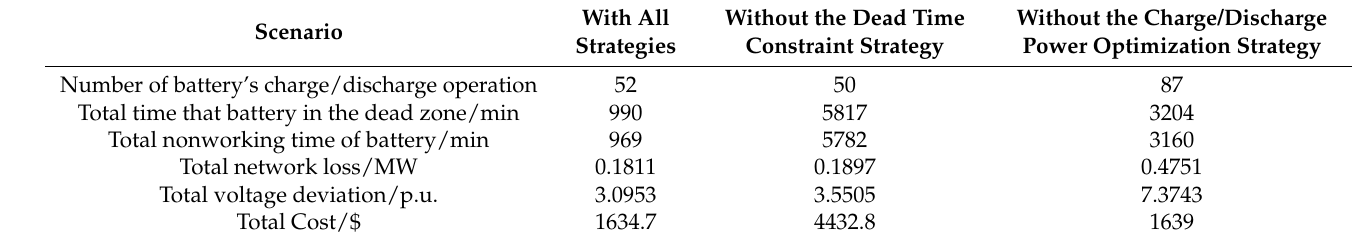
Table 2. The dispatching results of spring scenario with or without each strategy.